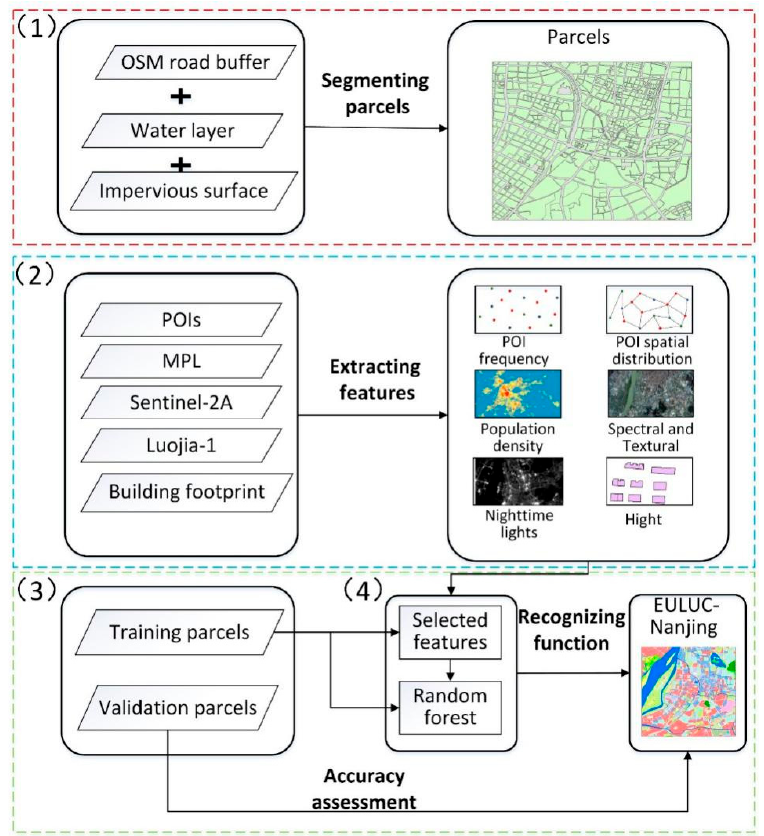
Figure 2. Procedures of mapping EULUC-Nanjing [12].